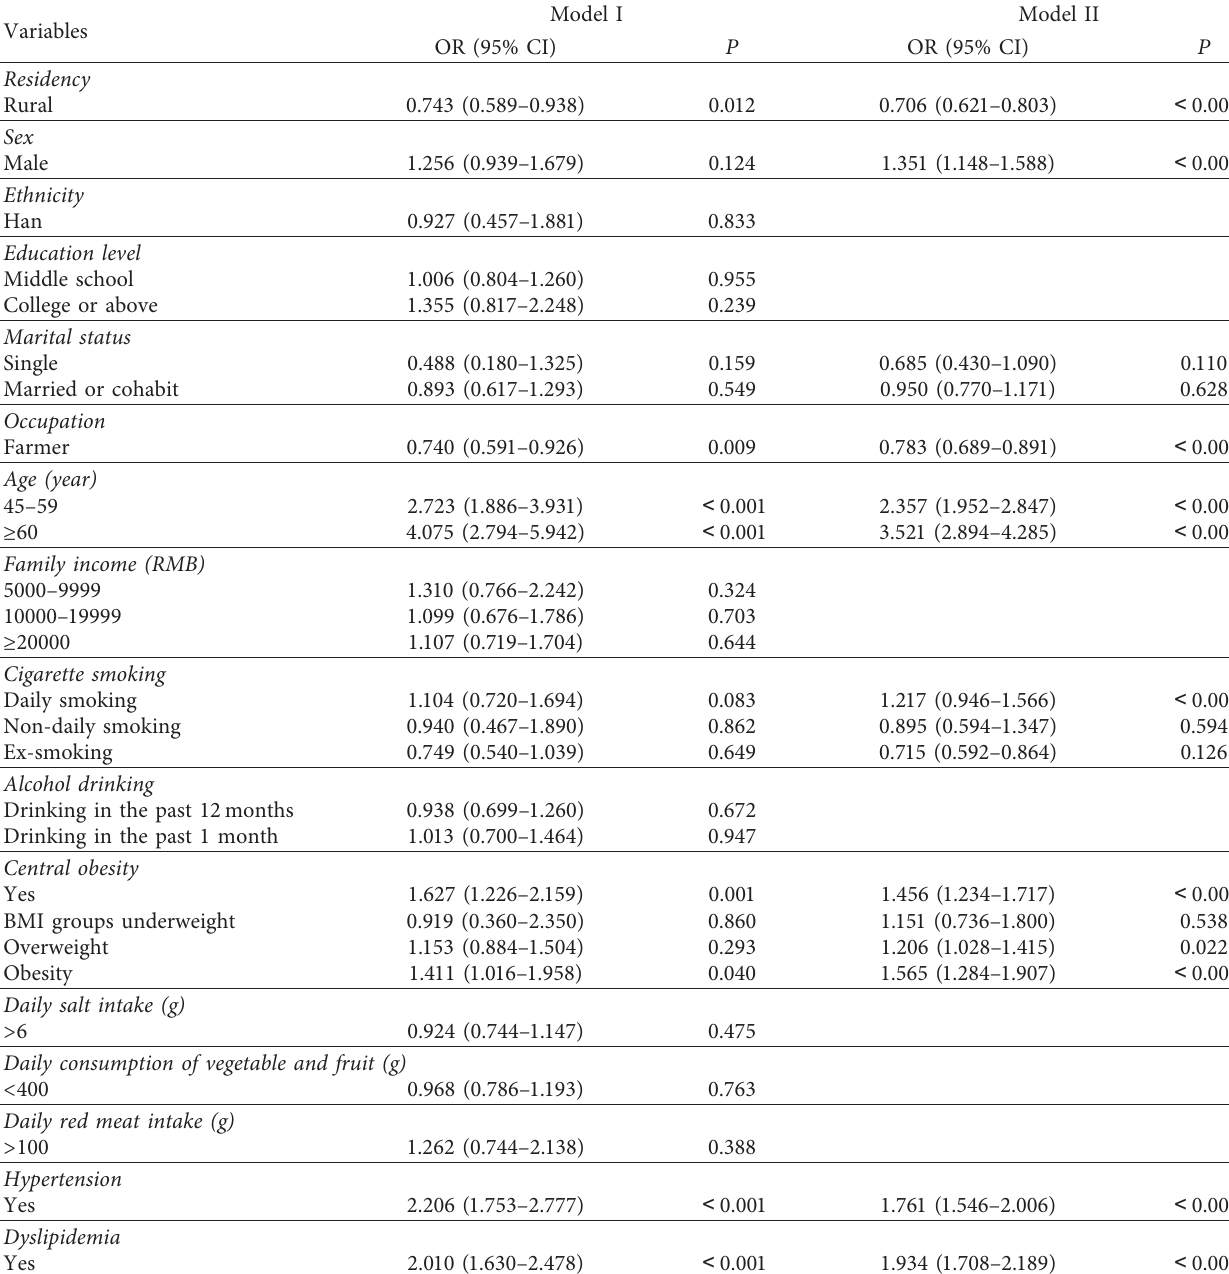
Table 4: Logistic regression analysis on risk factors of diabetes among adults from northwest